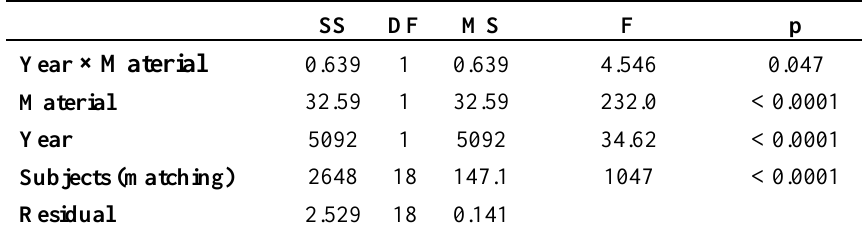
Table A1.5. Repeated measure ANOVA of sediment load over time and material (particulate vs. sediment).